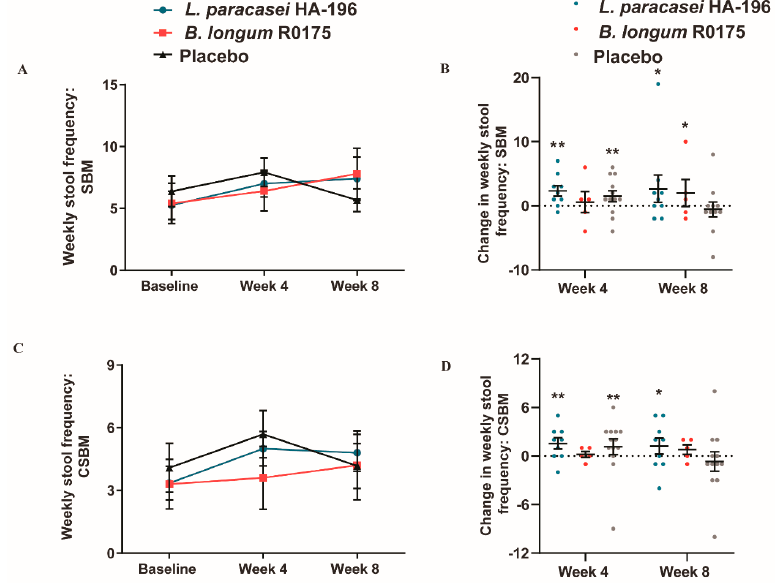
Figure 5. Effect of Lactobacillus paracasei HA-196 and Bifidobacterium longum R0175 on frequency of bowel movements in participants with IBS-C. ( A ) Weekly SBM at baseline, week 4 and week 8, ( B ) Change in total SBM from baseline to week 4 and week, ( C ) Total CSBM at baseline, week 4 and week 8, and ( D ) Change in weekly CSBM from baseline to week 4 and week 8. L. paracasei group n = 9, B. longum group n = 5, placebo group n = 13; data represented as mean ± SD; * p < 0.05, ** p < 0.01; SBM; spontaneous bowel movement; CSBM, complete spontaneous bowel movement; L. paracasei , Lactobacillus paracasei HA-196; B. longum, Bifidobacterium longum R0175. IBS-C participants consuming L. paracasei reported a significant 49% increase in CSBM at week 4, and a significant 43% increase at week 8 ( p = 0.004 and p = 0.02, respectively). Whereas, the placebo group had reported a significant 39% increase ( p = 0.04) at week 4 in the number of CSBM, but by the end of the study period a non-significant 2.2% decrease was reported from baseline (Figure 5C,D).